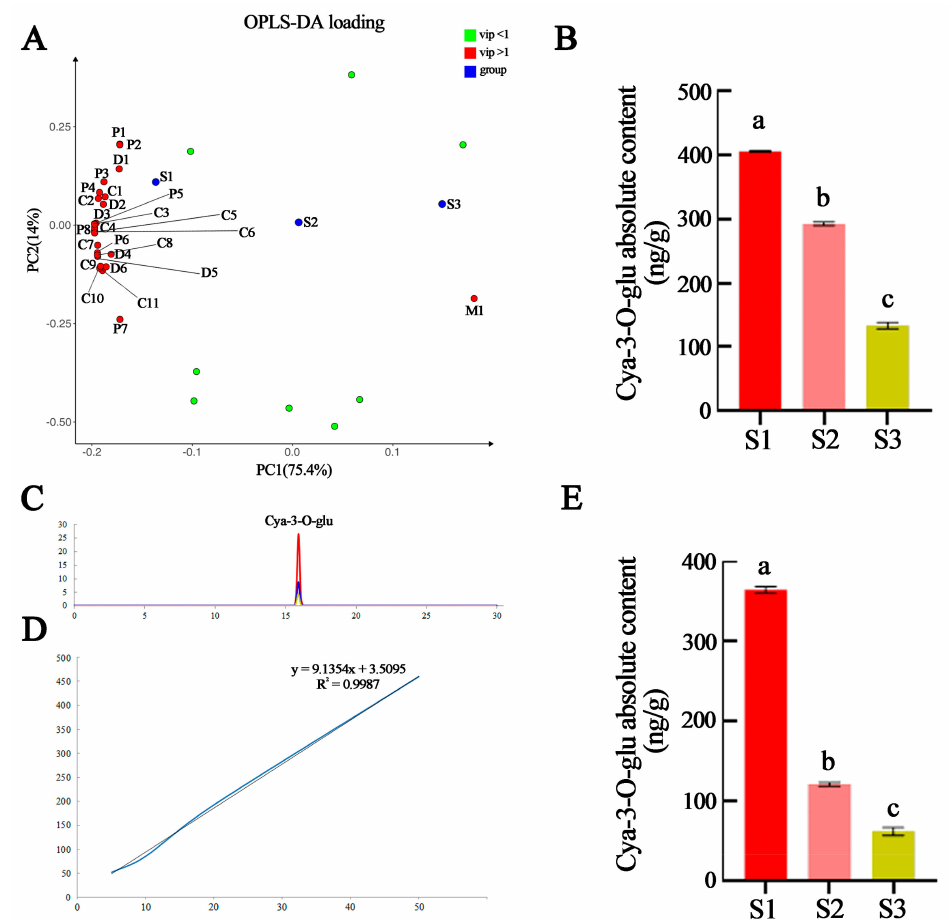
Figure 3. Identification of key metabolites between red P. bournei leaves in three developmental stages. ( A ) The orthonormal partial least squares regression–discriminant analysis (OPLS-DA) loading plot of anthocyanin levels of the leaves in three developmental stages. P1, peonidin 3,5-O- diglucoside (peo-3,5-diglu); P2, peonidin-3-O-(6-O-p-coumaryl)-glucoside (peo-3-O-(6-O-malonyl)- glu); P3, petunidin 3-O-arabinoside (pet-3-O-ara); P4, peonidin 3-O-glucoside (peo-3-O-glu); P5, peonidin 3-O-rutinoside (peo-3-O-rut); P6, pelargonidin 3-O-rutinoside (pel-3-O-rut); P7, peonidin-3- O-(6-O-p-coumaryl)-glucoside (peo-3-O-(6-O-coumaryl)-glu); P8, pelargonidin 3-O-glucoside (pel- 3-O-gly); D1, delphinidin 3-O-arabinoside (del-3-O-ara); D2, delphinidin 3-O-sophoroside(del-3-O- sop); D3, delphinidin 3-O-galactoside (del-3-O-gla); D4, delphinidin 3-O-glucoside (del-3-O-glu); D5, delphinidin 3-O-rutinoside (del-3-O-rut); D6, delphinidin-3-rutinoside 5-glucoside (del-3-rut- 5-glu); C1, cyanidin-3-O-(coumaryl)-glucoside (cya-3-O-(coumaryl)-glu); C2, cyanidin-3-rutinoside 5-glucoside (cya-3-O-rut-5-O-glu); C3, cyanidin 3-O-arabinoside (cya-3-O-ara); C4, cyanidin 3,5- O-diglucoside (cya-3,5-O-diglu); C5, cyanidin-3-O-xyloside (cya-3-O-xyl); C6, cyanidin 3-O-(6-O- malonyl-beta-D-glucoside) (cya-3-O-(6-O-malonyl)-glu); C7, cyanidin 3-O-galactoside (cya-3-O-gal); C8, cyanidin 3-O-rutinoside (cya-3-O-rut); C9, cyanidin 3-O-glucoside (cya-3-O-glu); C10, cyanidin 3-O-sophoroside (cya-3-O-sop); C11, cyanidin 3-O-sambubioside (cya-3-O-sam); M1, malvidin 3-O- glucoside (mal-3-O-glu). ( B ) Absolute levels of cya-3-O-glu were measured by anthocyanin-targeted metabolism analysis. Means of different treatment groups (different lowercase letters indicate significant differences) had a significant difference at p ≤ 0.05; ( C ) chromatograms of cya-3-O-glu in P. bournei leaves at different developmental stages as determined by High-performance liquid chromatography (HPLC); ( D ) standard curve created using cya-3-O-glu standard concentrations; ( E ) absolute levels of cya-3-O-glu measured by HPLC. Means of different treatment groups (different lowercase letters indicate significant differences) had a significant difference at p ≤